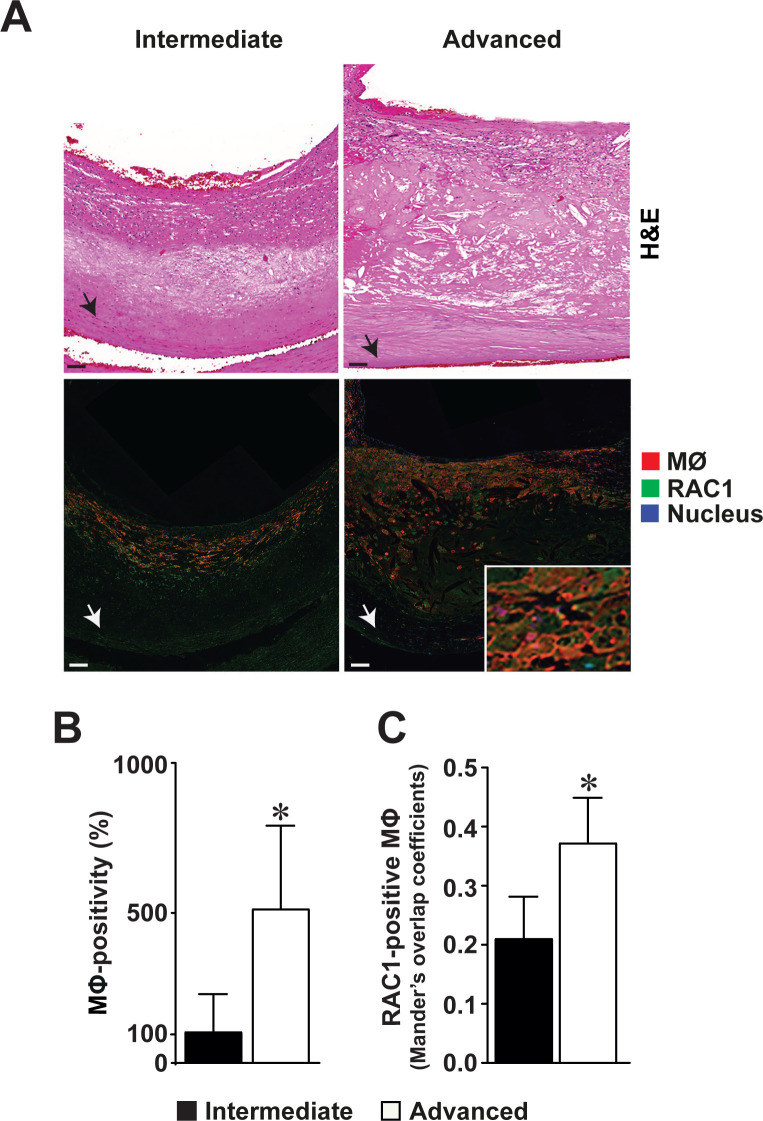
Increased RAC1 expression in intimal macrophages of advanced human atherosclerotic carotid plaques.(A) Hematoxylin & Eosin-stained sections of intermediate and advanced atherosclerotic plaques in human carotid endarterectomies (upper panels). Immunofluorescence detection of RAC1 (green), and macrophages (red, MΦ) in the intermediate and advanced atherosclerotic plaques (lower panels). Nuclear staining by DAPI (blue). Arrowhead points to the internal elastic lamina bordering the intimal thickening from the medial layer. Scale bars represent 100 μm. Co-localization of RAC1 expression in MΦ in an advanced intimal thickening shown in enlarged inset. (B) Number of macrophages in intermediate and advanced atherosclerotic plaques. (C) Number of macrophages expressing RAC1 expression within the intimal thickening of intermediate and advanced atherosclerotic plaques. Mean ± SEM values (n = 9 in each). Wilcoxon signed-rank test was used. *p<0.05.